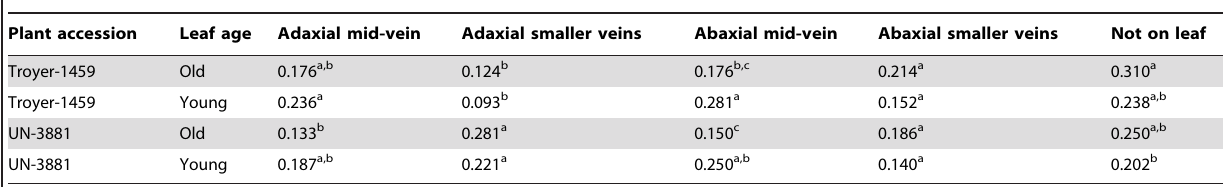
Table 3. Proportions of D. citri adults, per-settling site, on leaves of Troyer-1459 or UN-3881 plants based on chosen model (no. 5 in Table 1) that indicated that differences in settling patterns were associated with the interaction between plant accession and leaf age (Expt.